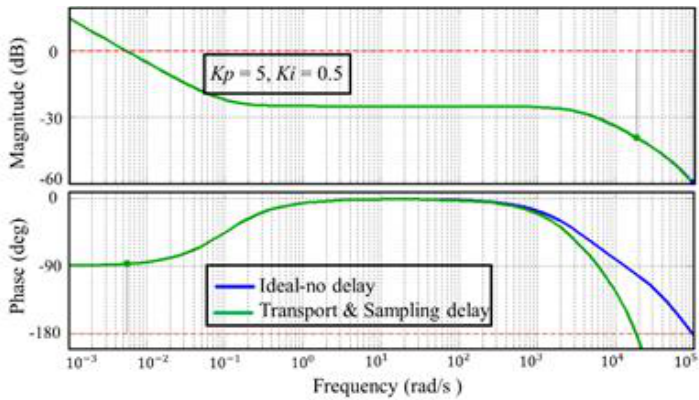
Figure 6. Bode plot of Open Loop Forward Path Gain for implemented controller.